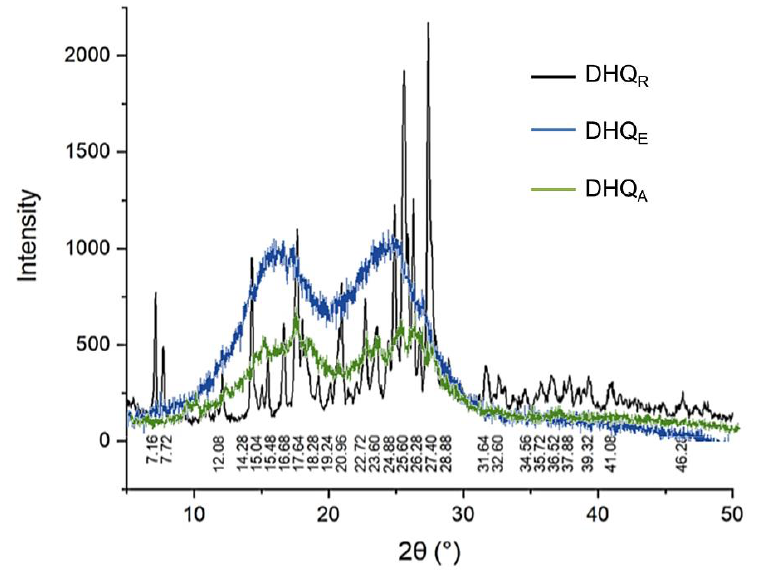
Figure 5. XRPD pattern of different DHQ forms at room temperature. The lyophilized samples were obtained from ethanol and acetonitrile solutions with 5% concertation of organic solvent.